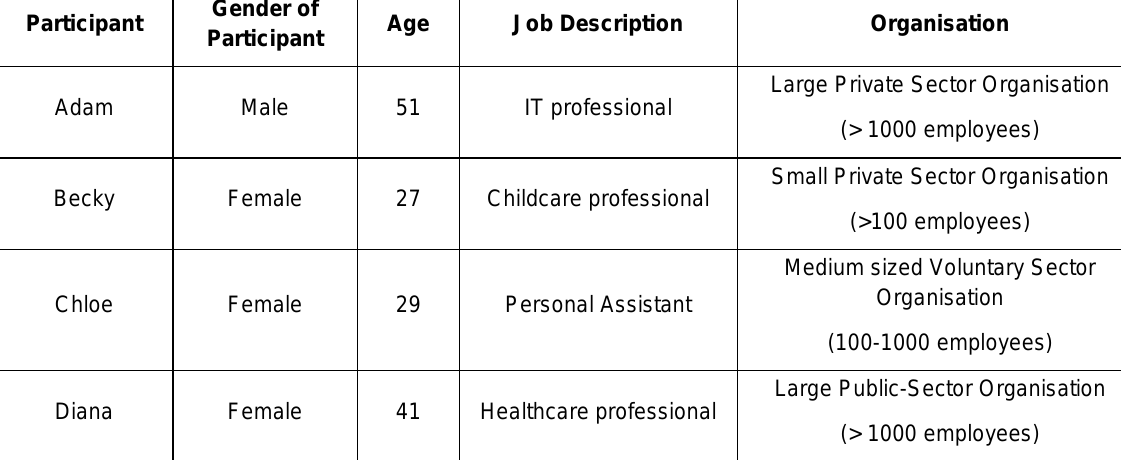
Table 1: Participant Demographics